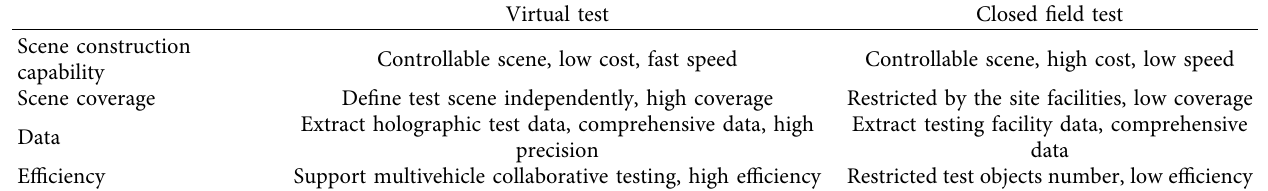
Table 3: Comparison of test